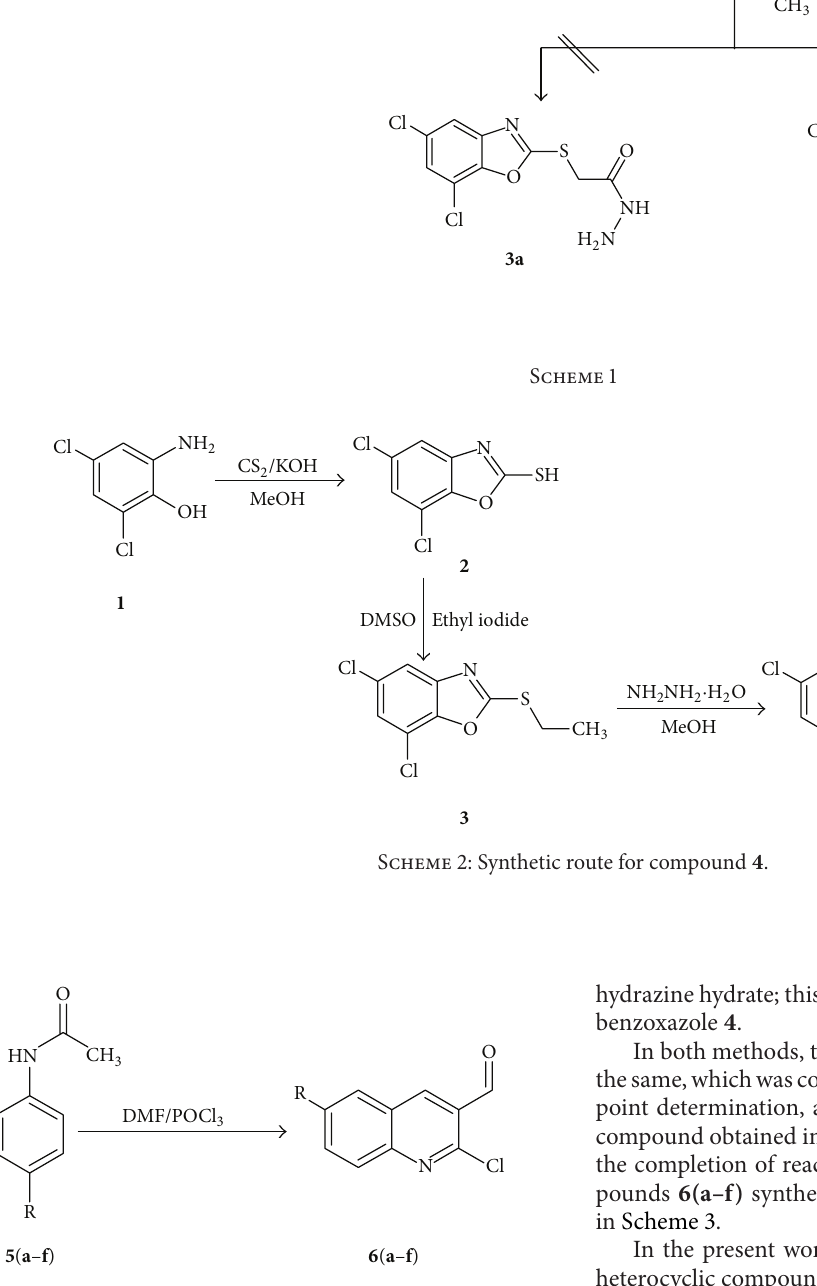
Scheme 3: Synthetic route for compounds 6(a–f)